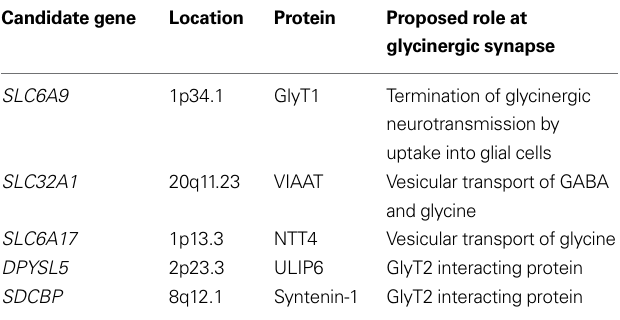
Table 3 | Candidate genes for mutation screening in